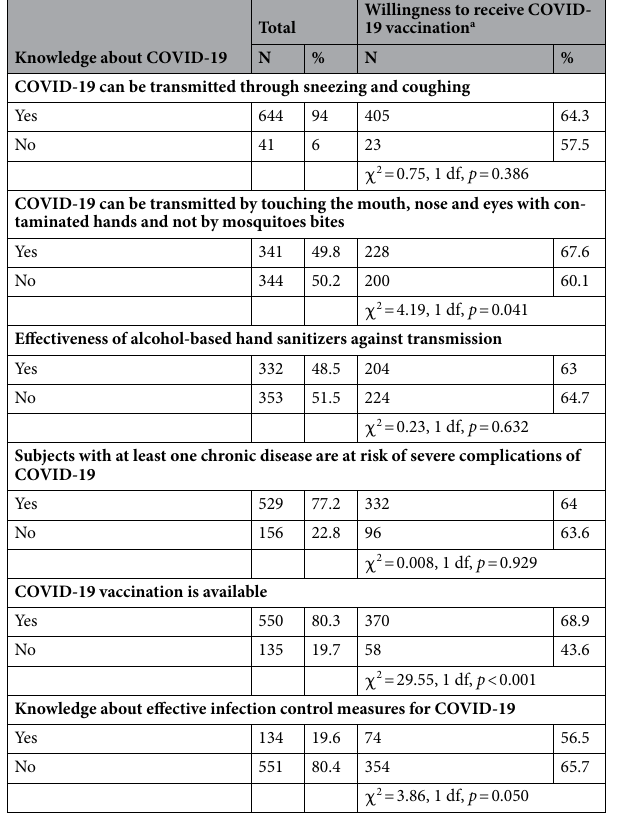
Table 2. Knowledge about COVID-19 and the associated willingness to receive COVID-19 vaccination (N = 865). a The frequency values of the respondents regarding the willingness to receive COVID-19 vaccination do not refer to the total number of the selected population due to the missing